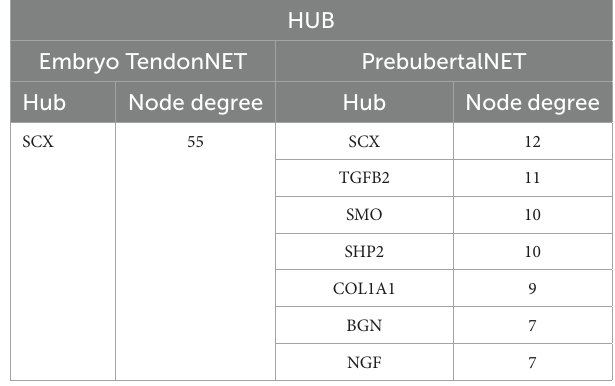
Based on the collected data, KEGG applied to TendonNETs allowed us to draw the backbone of the signaling supporting tenogenesis. KEGG analysis of the Enriched TendonNETs allowed to enrich the network map defining new paths and/or network links. This was clear by looking at the increased number of paths recognized